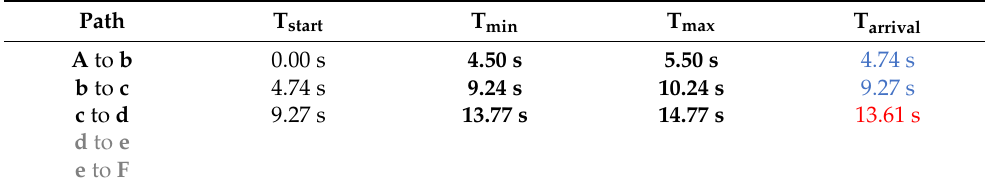
Figure 6. ( a ). Drone movement 2D log on abnormal case: too early. The vertical red line marks the moment when the drone detected an emergency and proceeded with an emergency landing. The wind was applied from the beginning of the mission, which is marked with a yellow line. Due to extreme wind conditions, the drone could not provide stable operations. ( b ). Time-window check results. The drone did not make it in the normal arrival time-windows on the path from c to d. The yellow line at the beginning indicates that extreme wind conditions were applied from the beginning of the flight. The red line indicates the moment where the event-based controller detected an abnormal situation due to early arrival. Table 2. The actual numerical time data including T start , T min , T max , and the actual arrival time T arrival for the extreme wind case. On the path from c to d, the T arrival was outside the time-window. The initial call for an emergency landing would have been 13.61 seconds away from the start of the mission. This is a considerably long period of time, but better than lacking the ability to detect such conditions with using PID controllers alone.